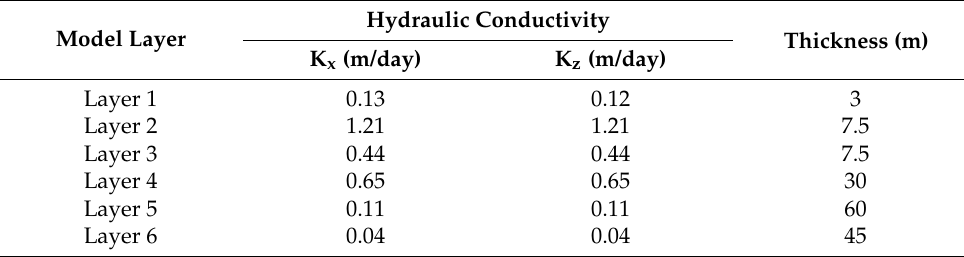
Table 2. Hydraulic conductivity and layer thickness values of the study